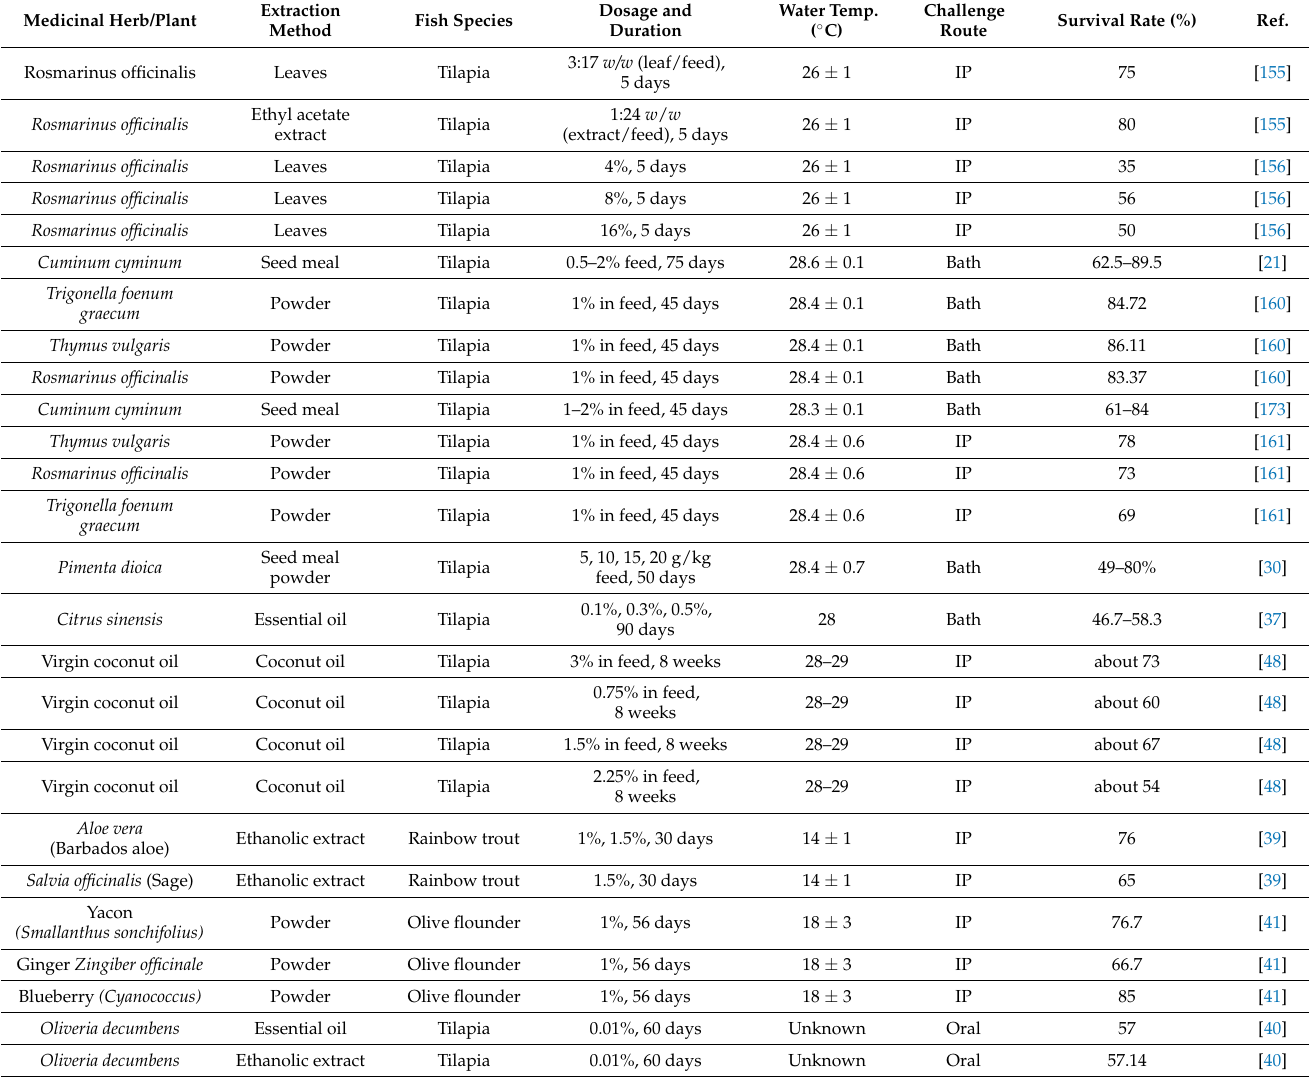
Table 2. In vivo disease resistance of medicinal/plants to S. iniae infection. IP = intraperitoneal injection, IM = intramuscular